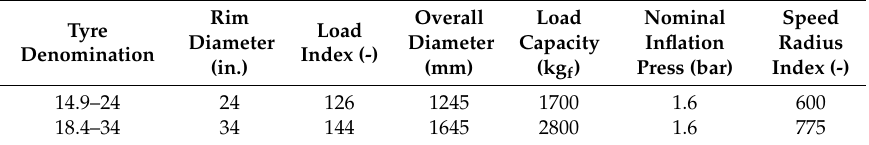
Table 6. Characteristics of the tyres equipping the “New Holland TL 90 4WD” farm